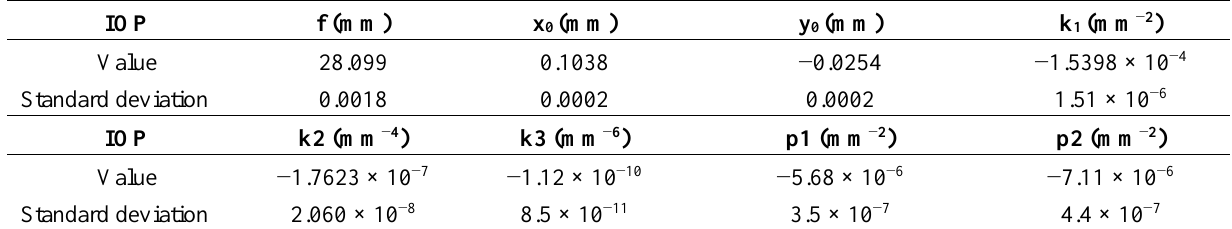
Table 6. Estimated interior orientation parameters and standard deviations.